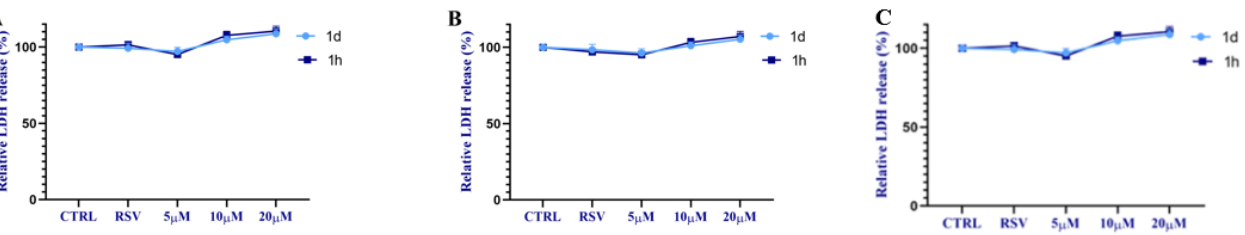
Figure 3. Evaluation of LDH % release after treatment with 1d and 1h on HUVECs ( A ), HGFs ( B ), and HOBs ( C ) at 5, 10, and 20 µM. Data were calculated as percentage means ± SD and compared to CTRL.